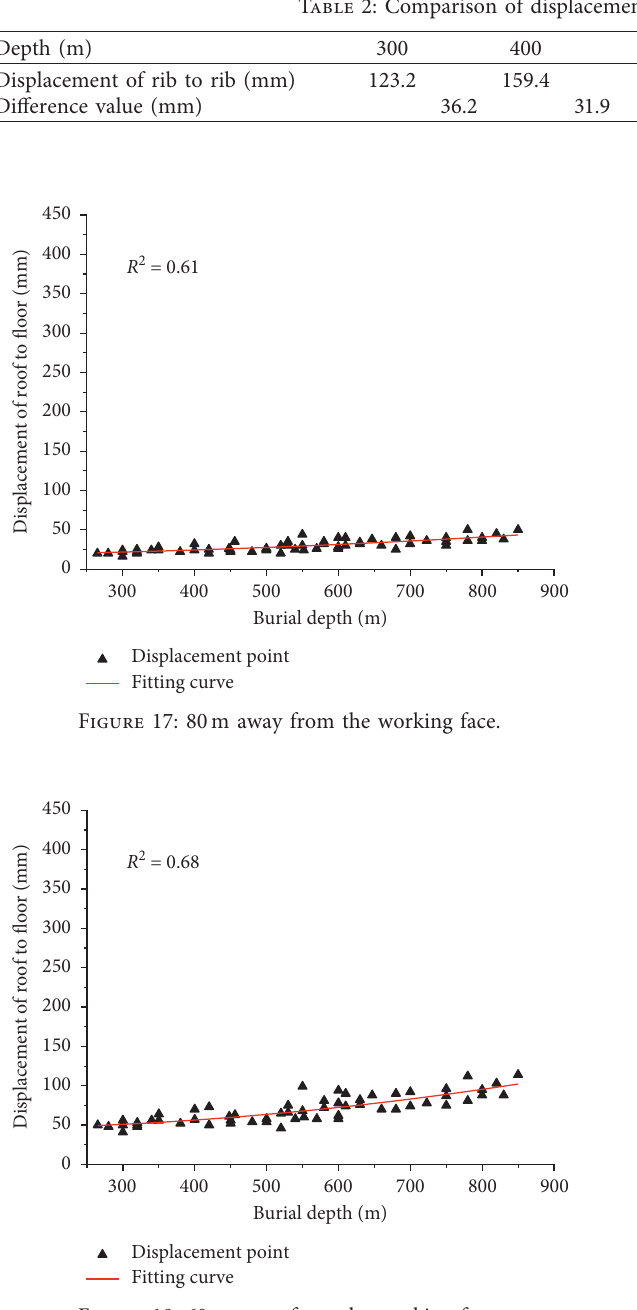
Figure 20: 20m away from the working